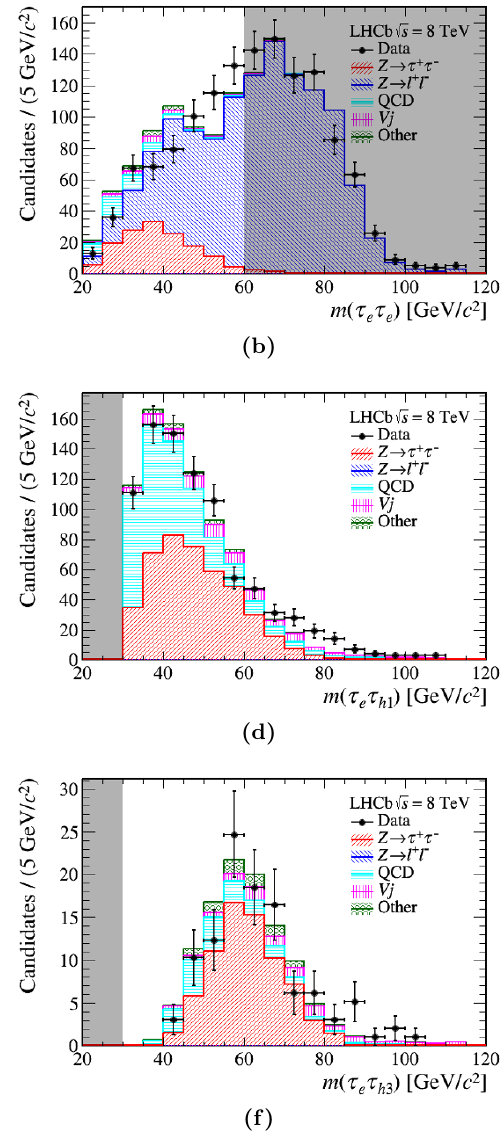
Figure 2 . Invariant-mass distributions for (a) (cid:28) (cid:22) (cid:28) (cid:22) , (b) (cid:28) e (cid:28) e , (c) (cid:28) (cid:22) (cid:28) h 1 , (d) (cid:28) e (cid:28) h 1 , (e) (cid:28) (cid:22) (cid:28) h 3 , (f) (cid:28) e (cid:28) h 3 , (g) (cid:28) (cid:22) (cid:28) e candidates with the excluded mass ranges indicated by the gray areas. The Z ! (cid:28) + (cid:28) (cid:0) simulation (red) is normalised to the observed signal. The Z (blue), QCD (brown), and electroweak (ma- genta) backgrounds are estimated from data. The tt , V V backgrounds and cross-feed (green) are estimated from simulation (see text) and generally not visible.